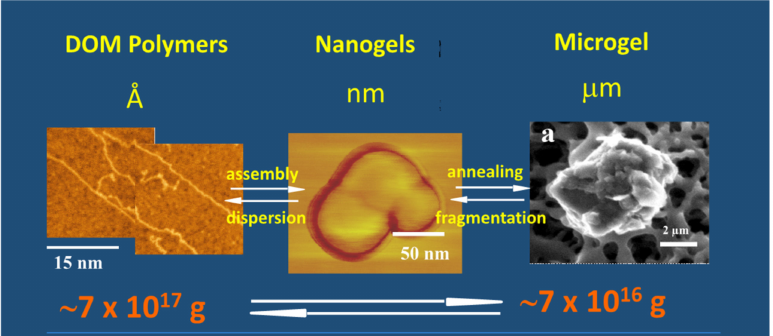
Figure 15. This figure shows that the formation of MG starts from biopolymer precursors at Angstroms dimensions ( left panel ). They self-assemble forming nanogels ( center panel ) that anneal to final equilibrium gel size at micron scales ( right panel ). MBP and nanogels were set on mica substrate for ATM imaging. A filter surface can be seen in the background of the ESEM image on the right. Arrows indicate material flow between MBP, nanogels, and micron-size MG, and in the lower panel illustrate organic carbon mass equilibrium between DOM and